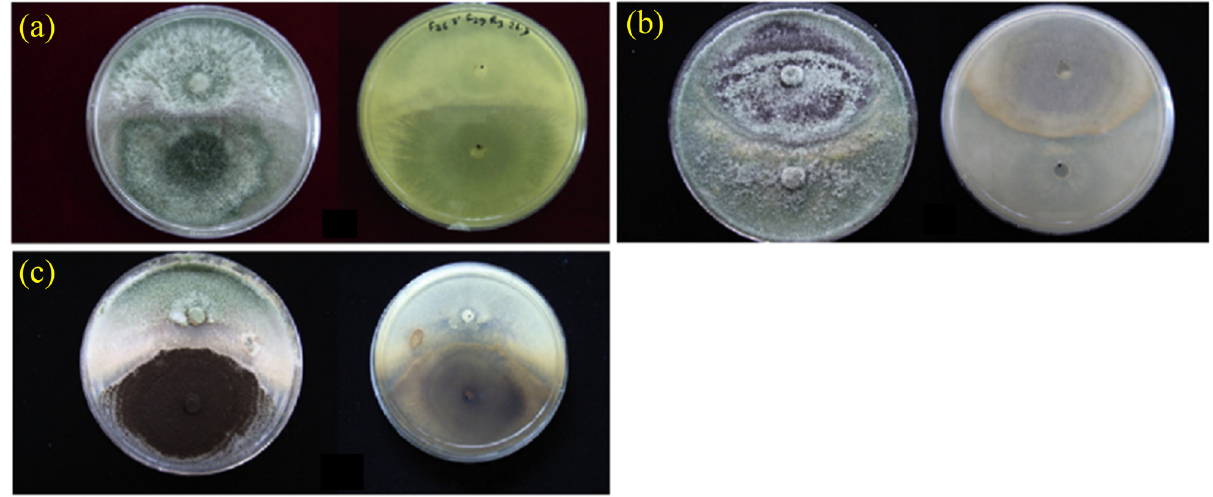
Figure 4: Interaction outcomes of di ff erent fungal isolates grown on PDA media. ( a ) Mutual intermingling; ( b ) partial mutual intermingling; and ( c ) deadlock at contact point [ 66 ]